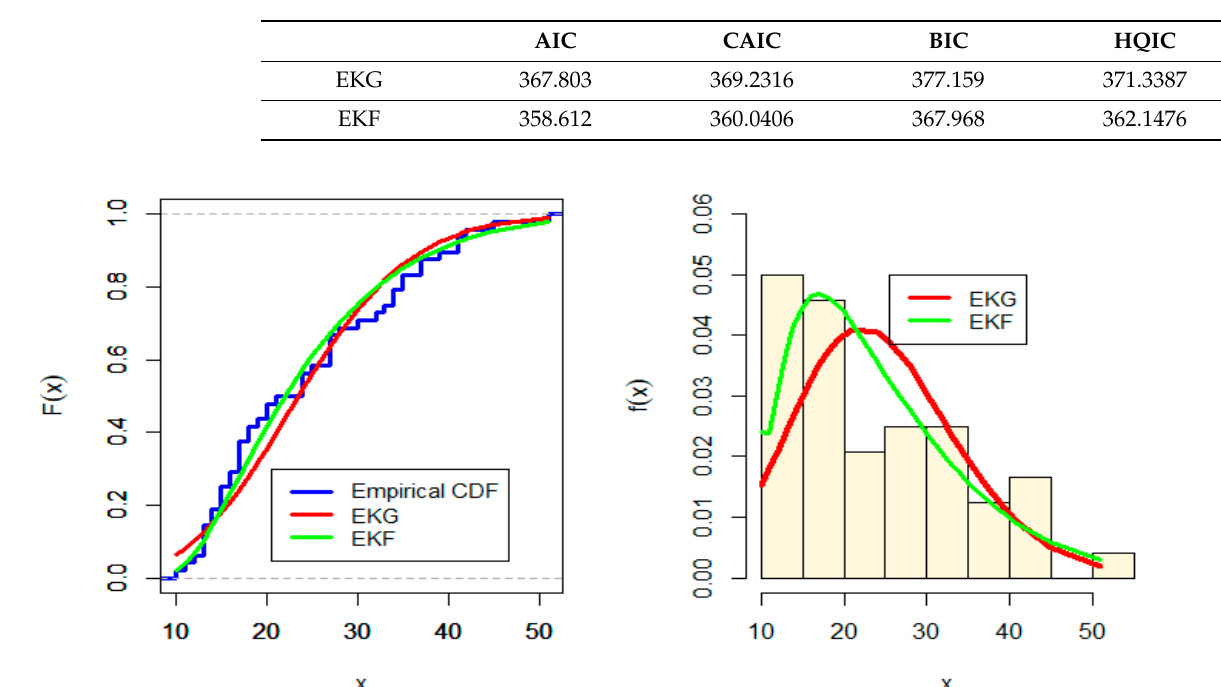
Figure 6. Estimated CDF and PDF for EKG and EKF distribution for Wire data.